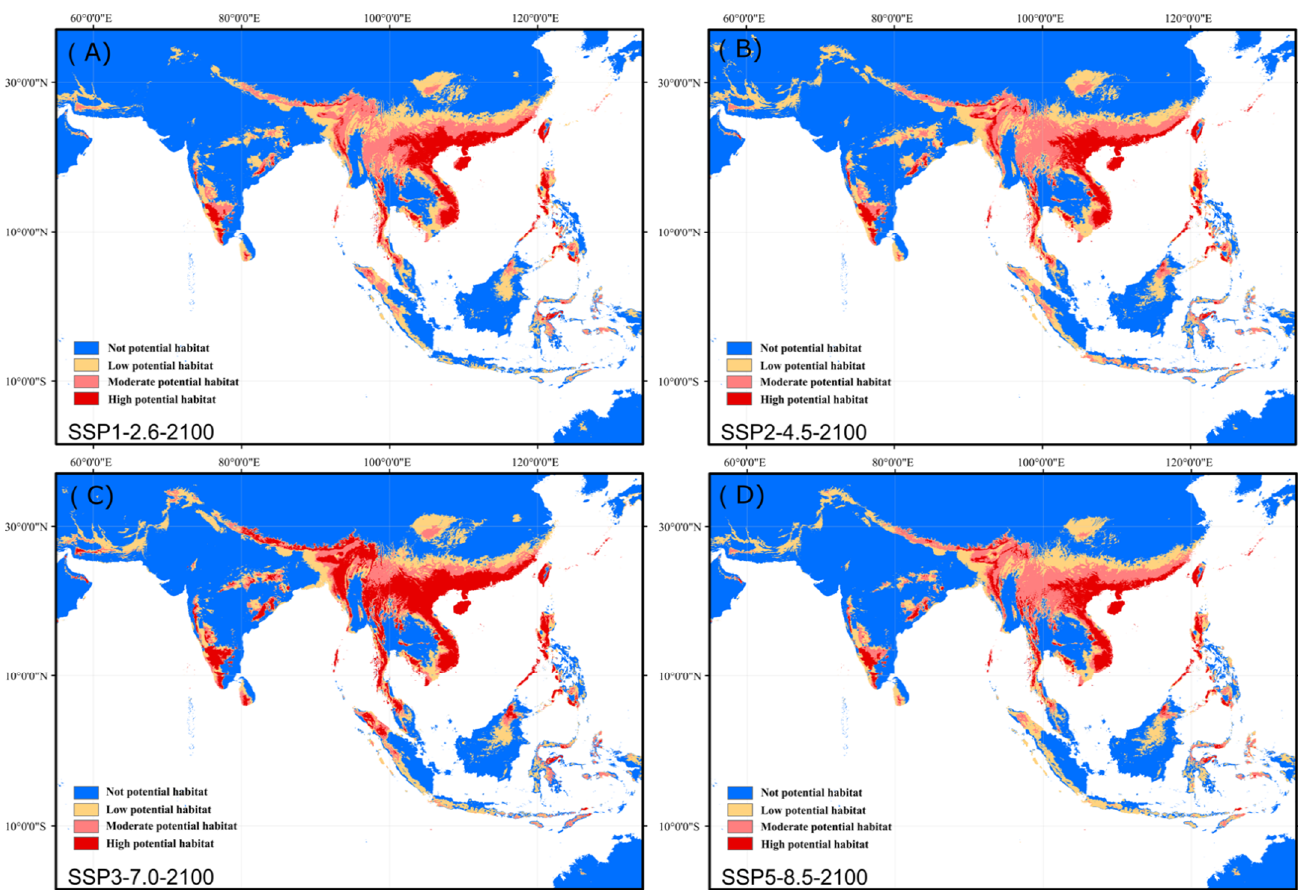
Figure 5. Prediction of the potential distribution area of N. chinensis in 2100 under four levels of greenhouse gas emission scenario: ( A ), the low-end SSP1-2.6 scenario; ( B ), the low-moderate SSP2-4.5 scenario; ( C ), medium-high SSP3-7.0 scenario; ( D ), the high SSP5-8.5 scenario.